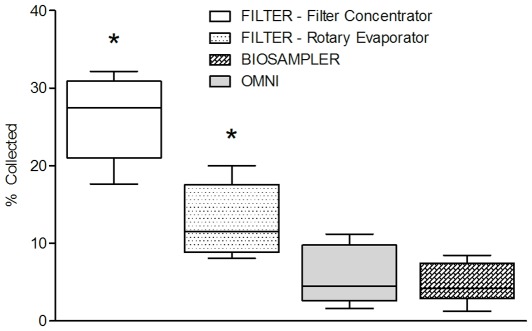
Comparison of mean collection efficiencies by sampling device type.Tukey Box Plot of mean collection efficiencies calculated using Equation 3 of six human cytokines using different collection devices in a single-pass aerosol chamber (N = 36; 3 filters assayed in duplicate for each of 6 different cytokines, 95% CI). * indicates significance at P<0.05.